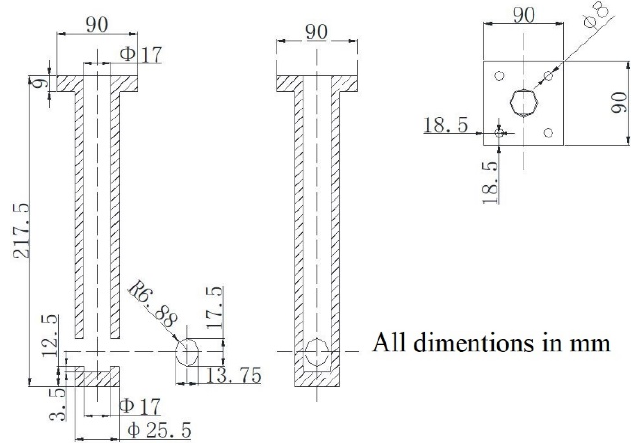
Figure 2. Water model experimental apparatus.